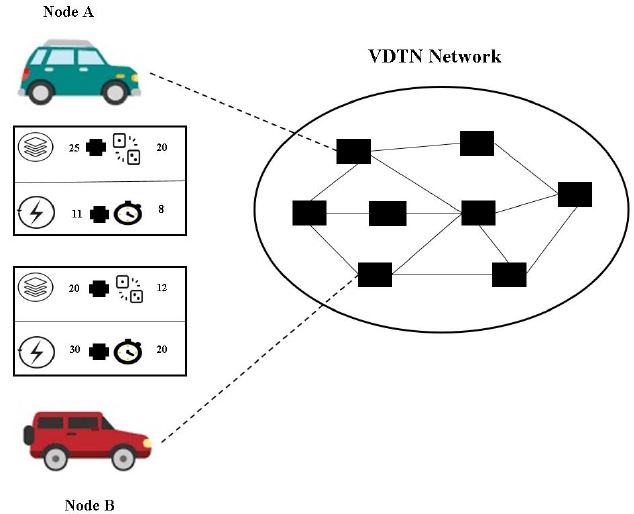
Figure 1. The n etwork’s circumstances from each node’s perspective . Figure 1. The network’s circumstances from each node’s perspective.